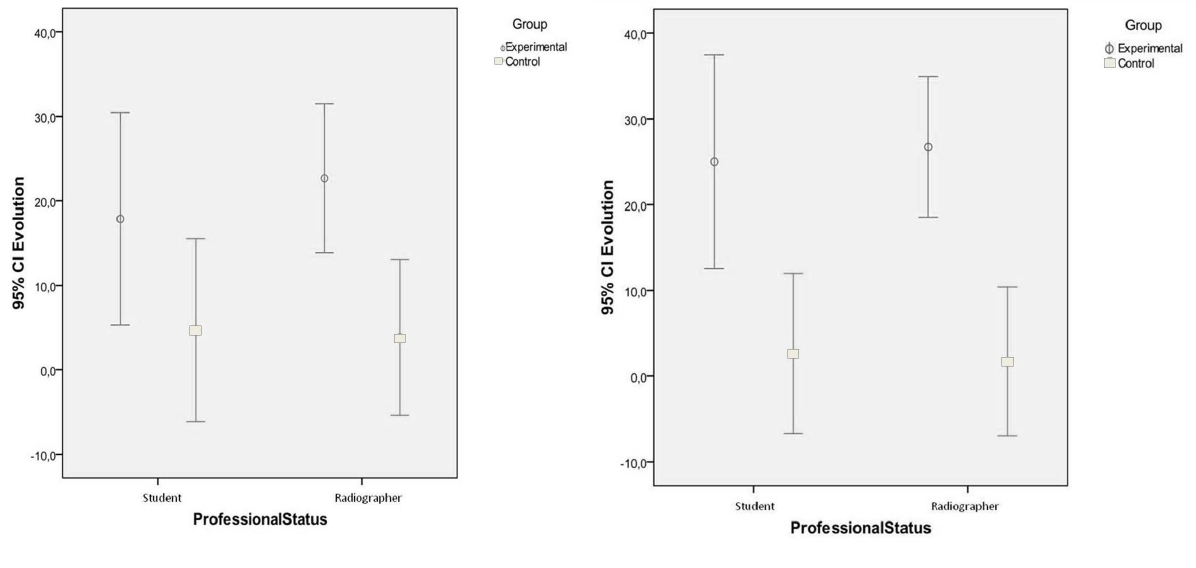
Figure 7. Improvement stratified by professional status. Left plot (intention-to-treat): Inconclusive result for students but clear effect for radiographers. Right plot (per-protocol): Clear effect for both students and